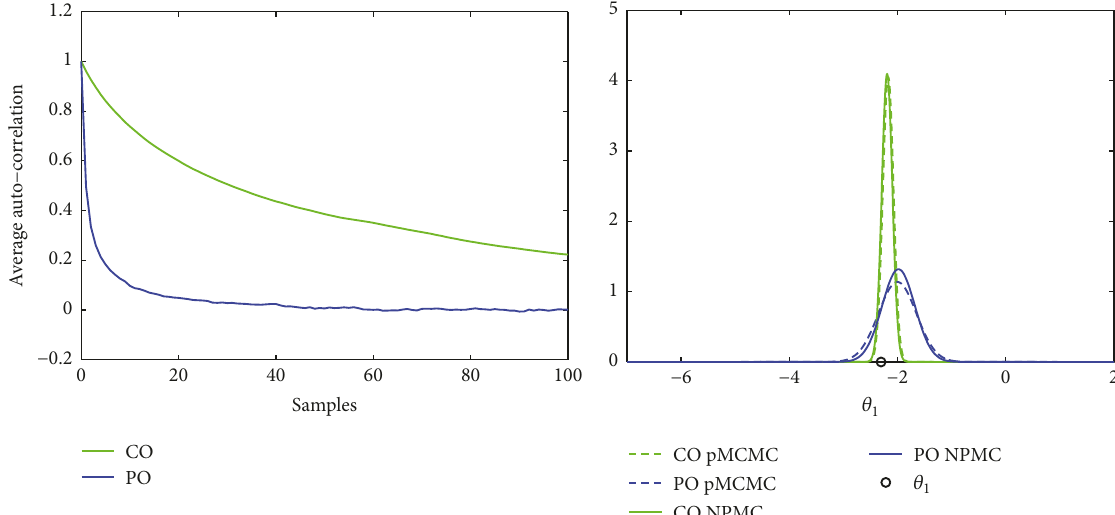
Figure 3: Left . Average ACF based on the final sample of size 𝑀 = 10 3 of the pMCMC scheme in the CO and the PO scenarios, averaged over 𝑃 = 100 simulation runs. Right . Marginal posterior pdf estimates ̂𝑝(𝜃 1 , | 𝜃 \1 , y ) of an average simulation run, for pMCMC and NPMC in the CO and PO scenarios. The true value 𝜃 1 is also shown.